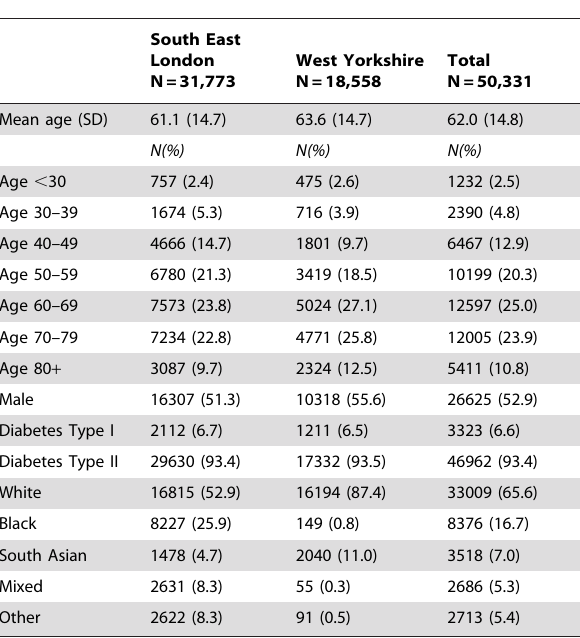
Table 2. Characteristics of the study